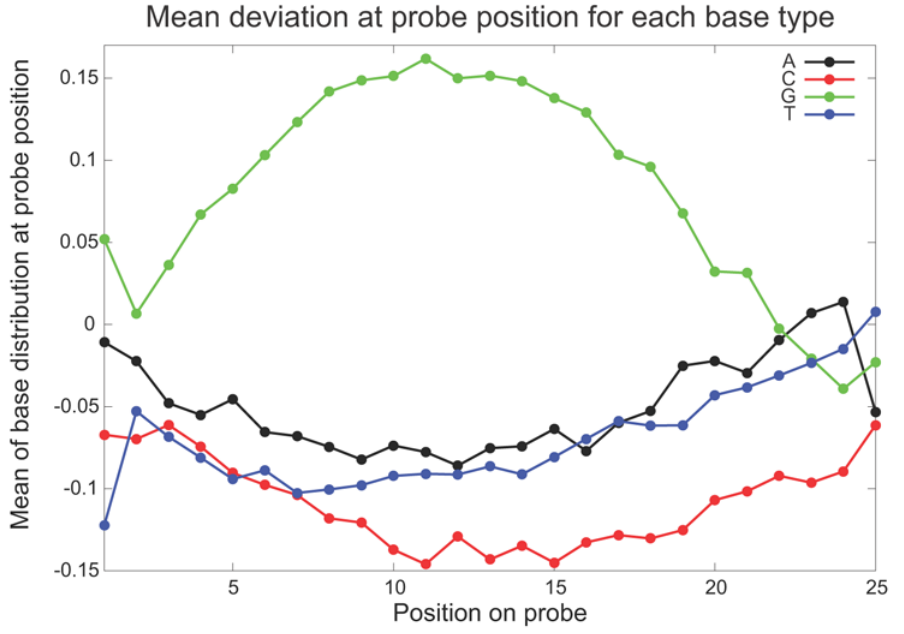
Figure 9. Probe nucleotide composition bias. Mean bias for each nucleotide type at each position along the probe for all probes within known annotated regions of the genome, illustrating the basis of the sequence dependence of individual probe biases.